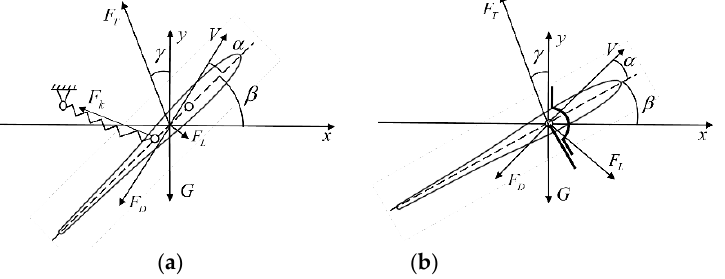
Figure 8. The force analysis of the hydrofoil during the ascent phase. ( a ) Conventional submerged glider; and ( b ) self-adjusting lower-limit submerged glider.